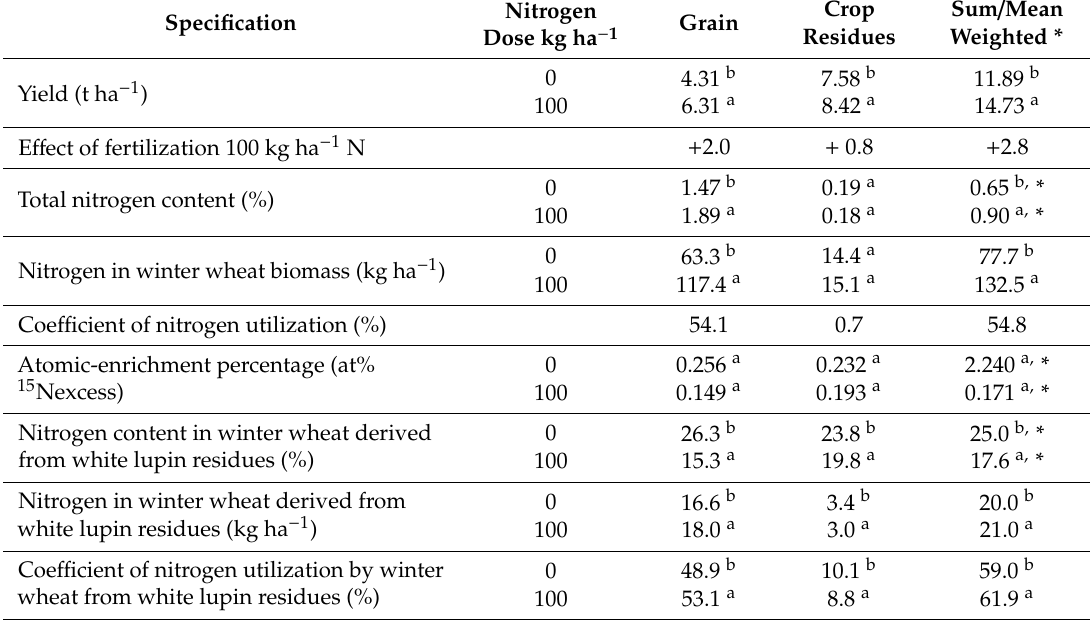
Table 4. Parameters of winter wheat harvested in